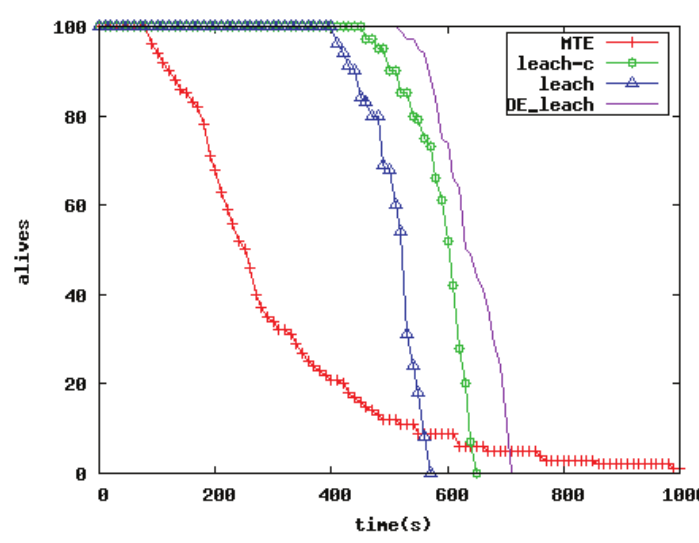
Figure 5. Comparison of WSN